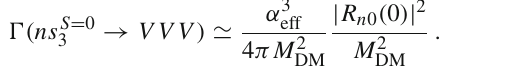
how close the DM annihilation cross-section is to the unitarity bound v . We derive the scale for s -wave annihilation (σv) J = 0 max = 4 π/ M 2 DM where EW gauge coupling will develop a Landau pole by integrating-in the WIMP multiplet at its freeze-out mass